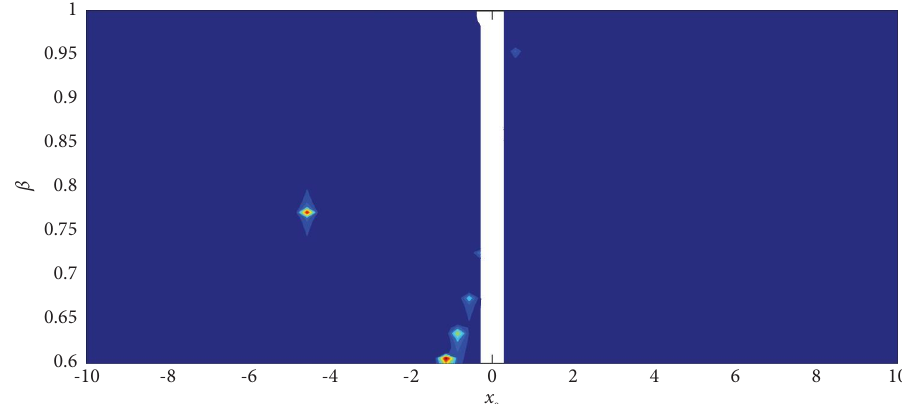
Figure 8: Convergence planes of second-order NR on f